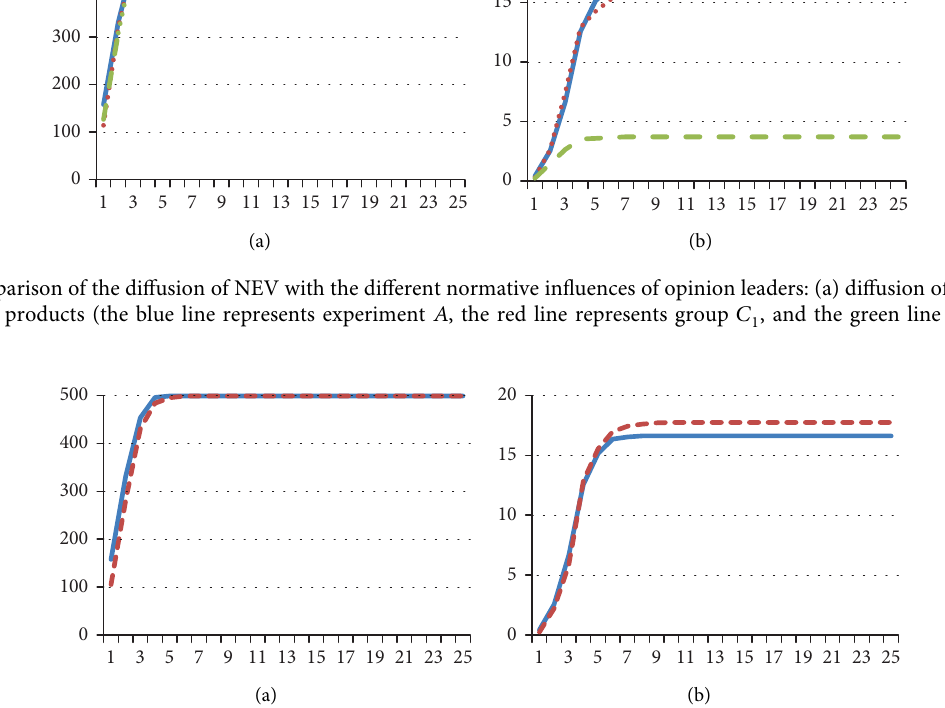
Figure 5: Comparison of the difusion of NEV with diferent judgment abilities of opinion leaders: (a) difusion of information and (b) difusion of products (the blue line represents experiment A and the red line represents experiment E ).